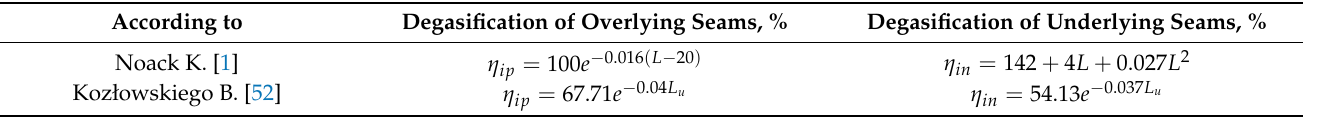
Table 3. The degree of methane drainage of seams disrupted by exploitation. According to Degasification of Overlying Seams, % Degasification of Underlying Seams, % Noack K. [1] η ip = 100 e − 0.016 ( L − 20 ) η in = 142 + 4 L + 0.027 L 2 Kozłowskiego B.